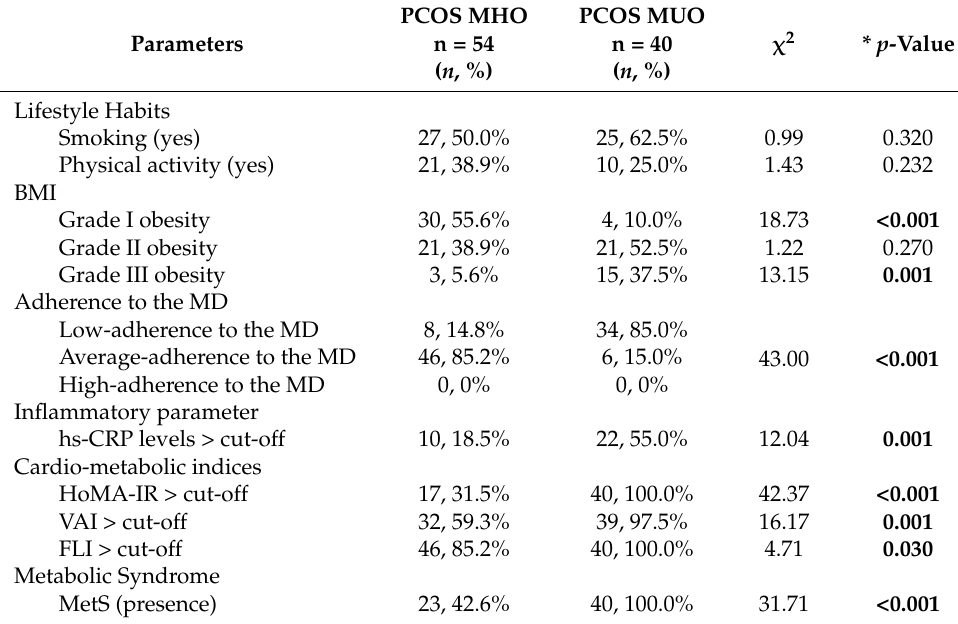
Table 4. Differences in categorical study parameters according to metabolically healthy versus metabolically unhealthy.